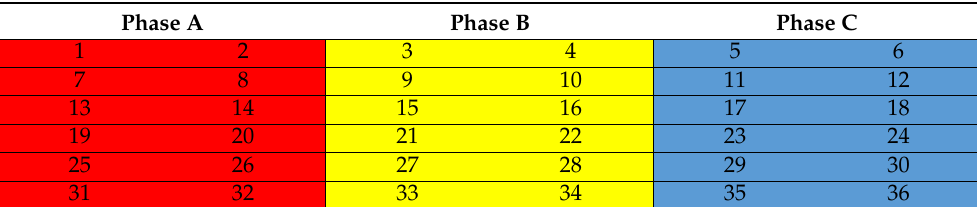
Table 9. Slot distribution to phases of M 1 .